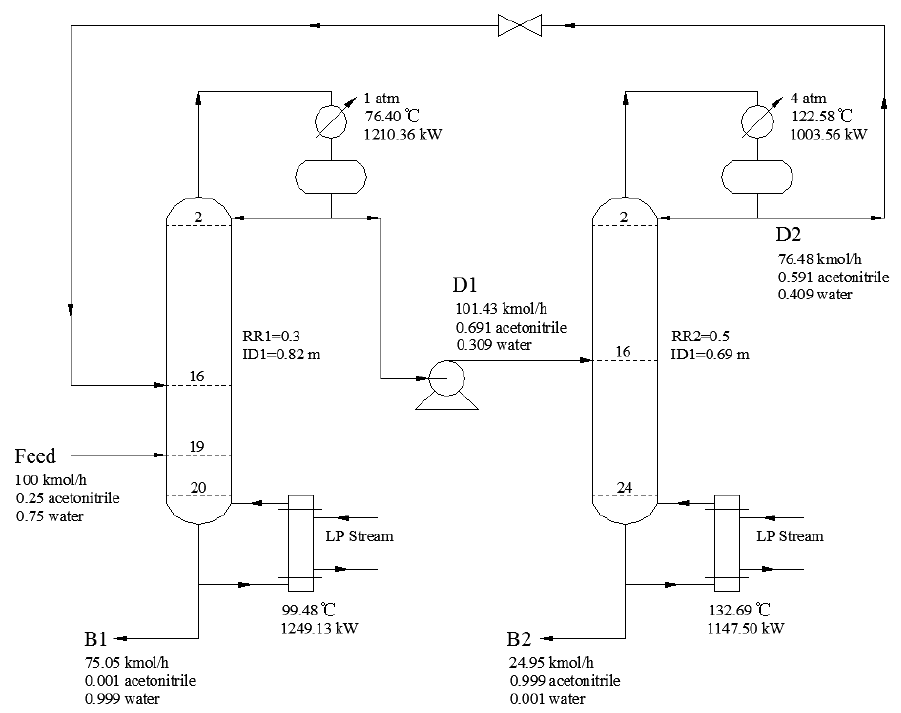
Figure 3. Optimized flow diagram of pressure swing distillation (PSD) without heat integration.